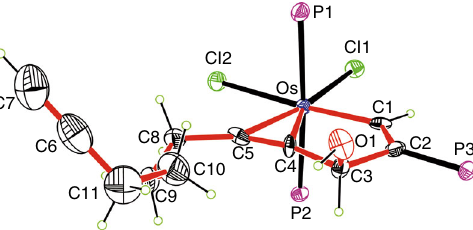
Fig. 9 X-ray molecular structure of complex 9 drawn with 50% probability. Phenyl groups in PPh 3 are omitted for clarity. Selected bond distances (Å) and bond angles (deg): Os – C1 2.019(7), Os – C4 2.153(7), Os – C5